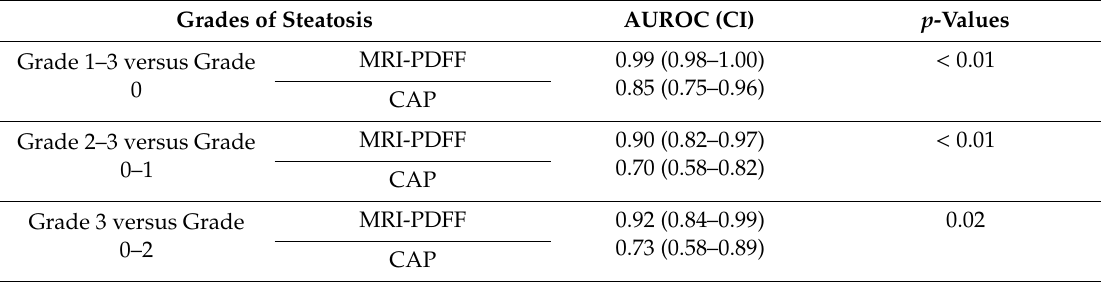
Table 4. Comparison of magnetic resonance imaging-proton density fat fraction (MRI-PDFF) and controlled attenuation parameter (CAP) for diagnosis of steatosis